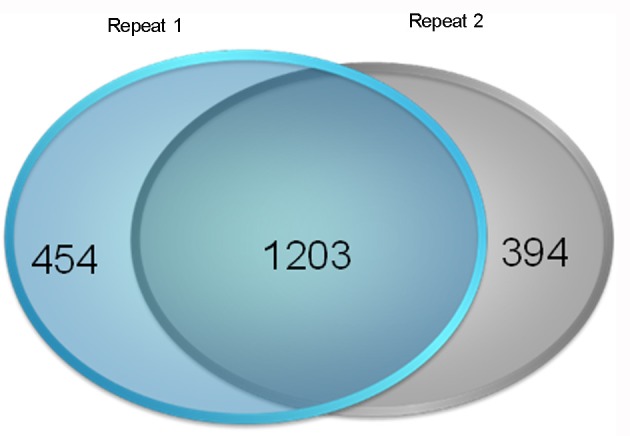
Results of the reproducibility of protein identification. Repeat 1: the first repetition of protein identification. Repeat 2: the second repetition of protein identification.